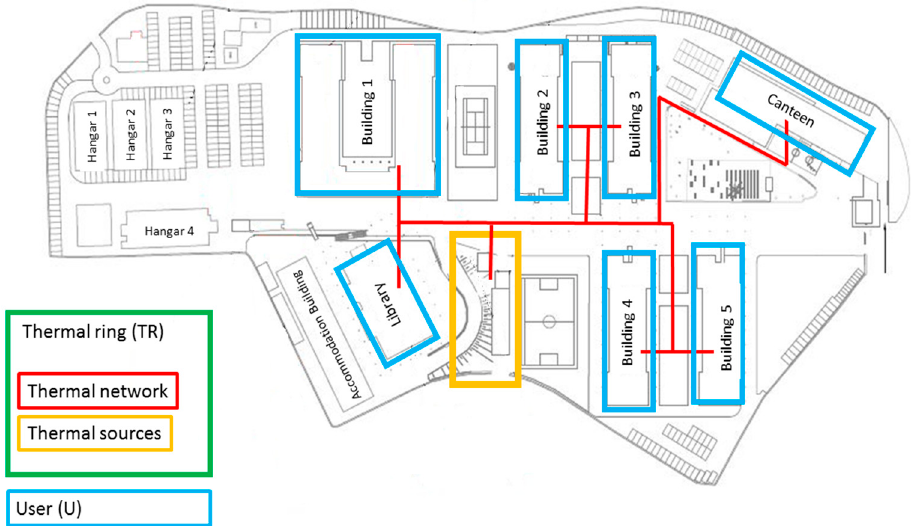
Figure 3. The SPM layout with the highlight of the “thermal ring” (the union of the thermal sources and the thermal network) and the “user” (the set of buildings involved).